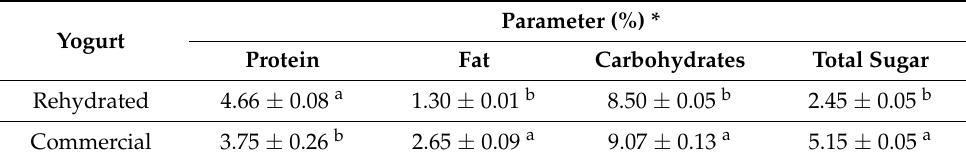
Table 7. Chemical composition.